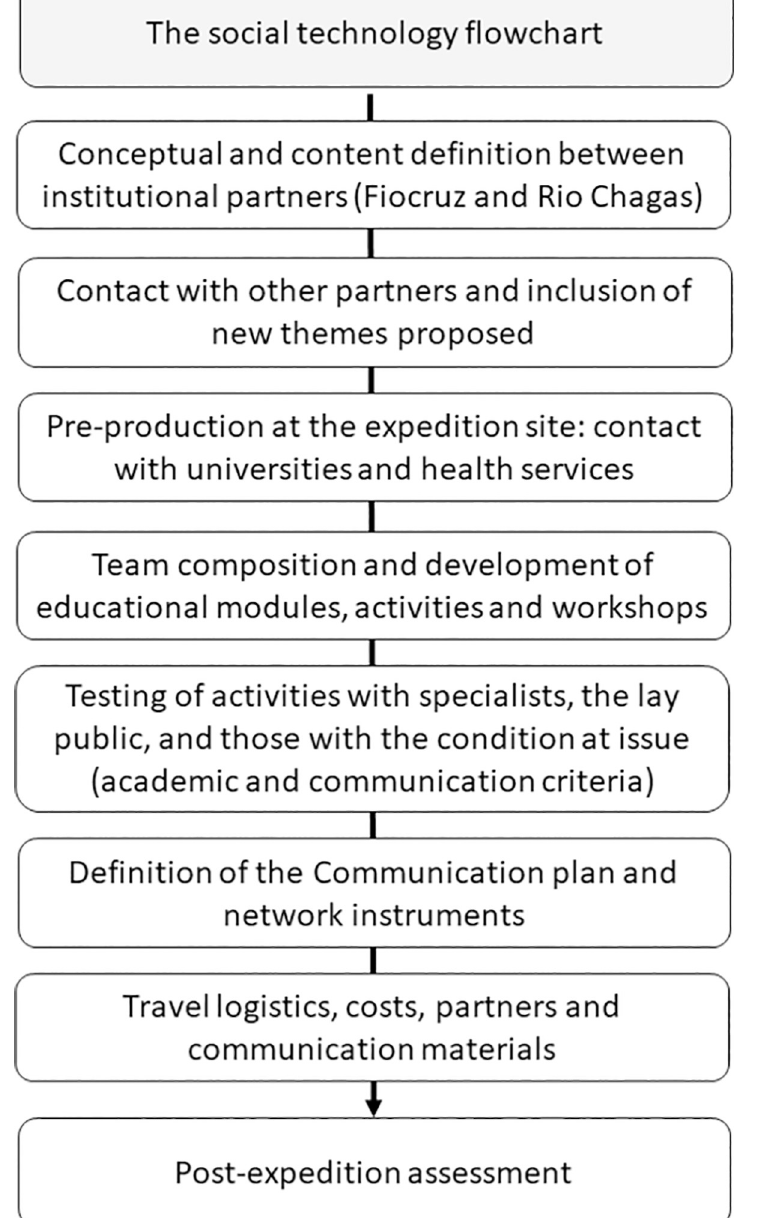
Fig 6. Flowchart of Chagas Express XXI educational social technology: an eight-step